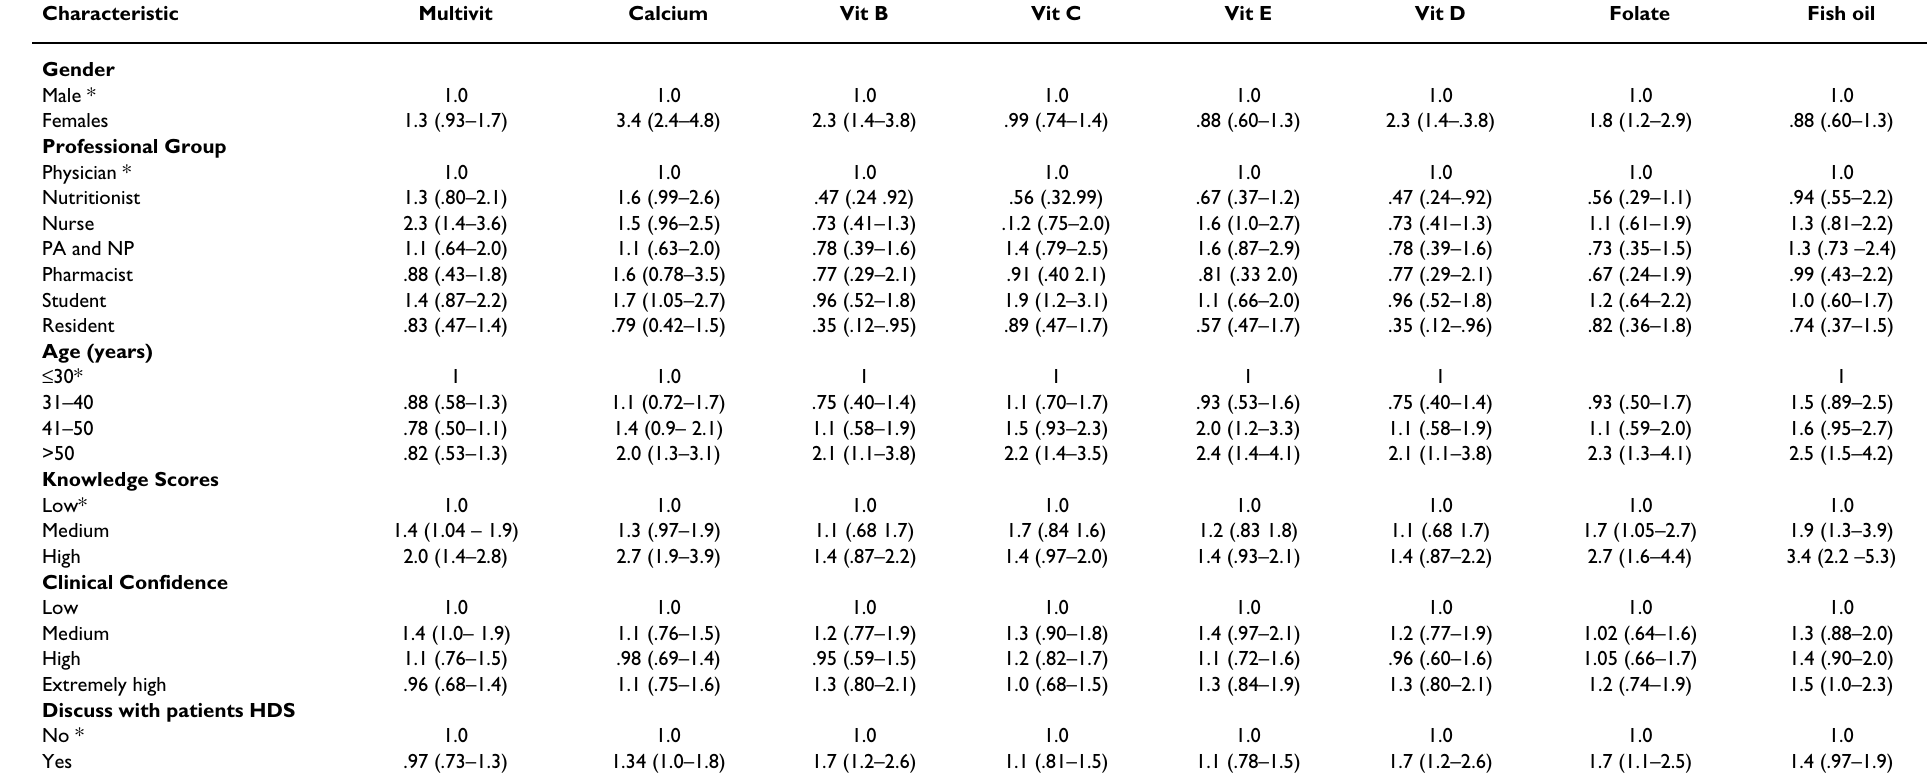
Table 3: Amongst health care professionals, factors associated with individual use of vitamins and minerals; adjusted multivariate logistic regression***